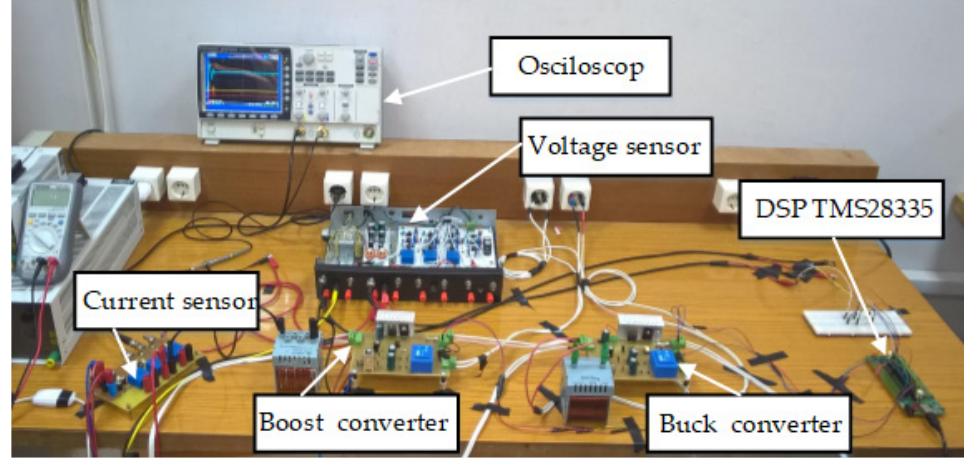
Figure 13. Experimental setup of the studied system.